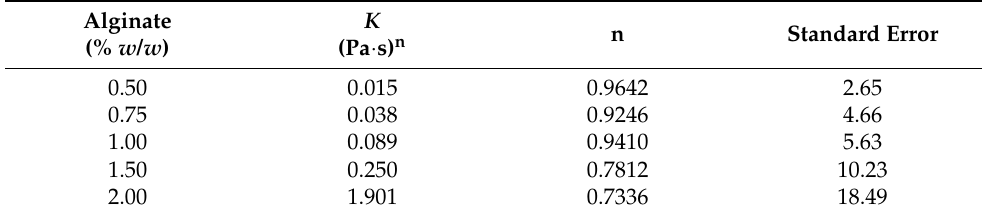
Table 2. Pseudoplastic parameters of alginate